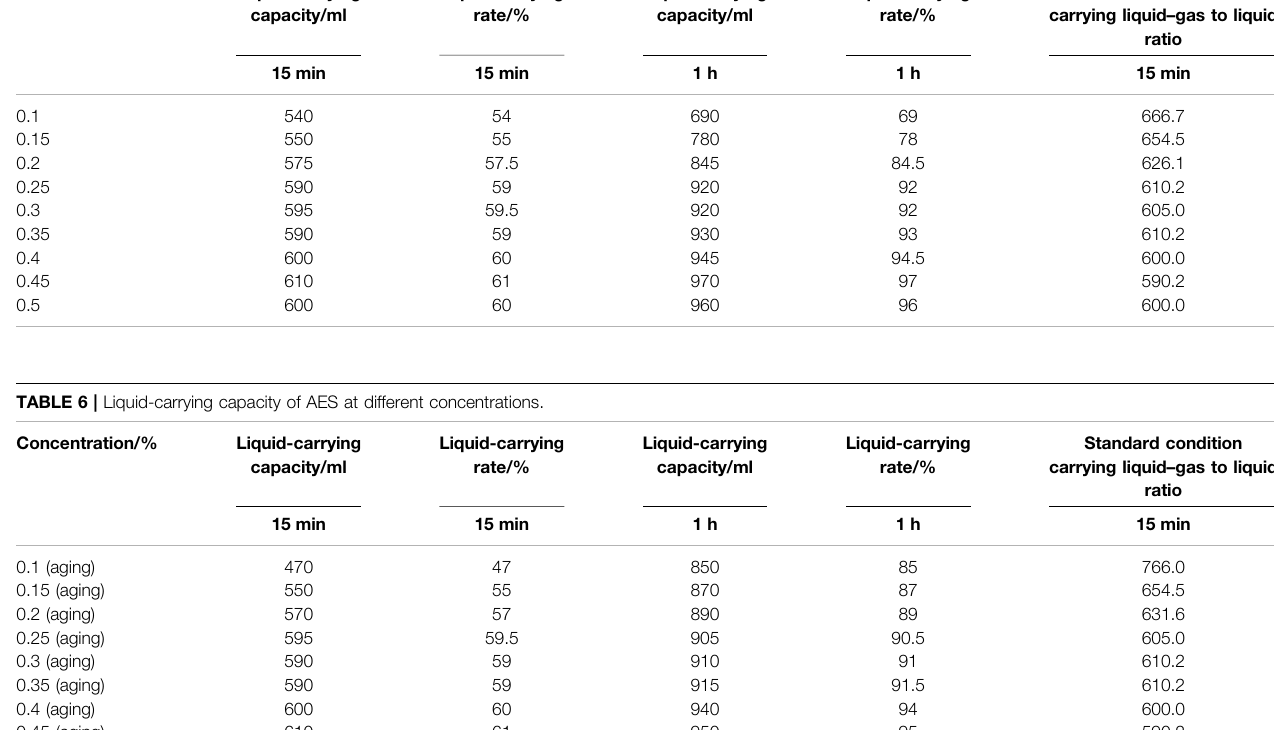
TABLE 5 | Liquid-carrying capacity of ZHY-01 at different concentrations. Concentration/%